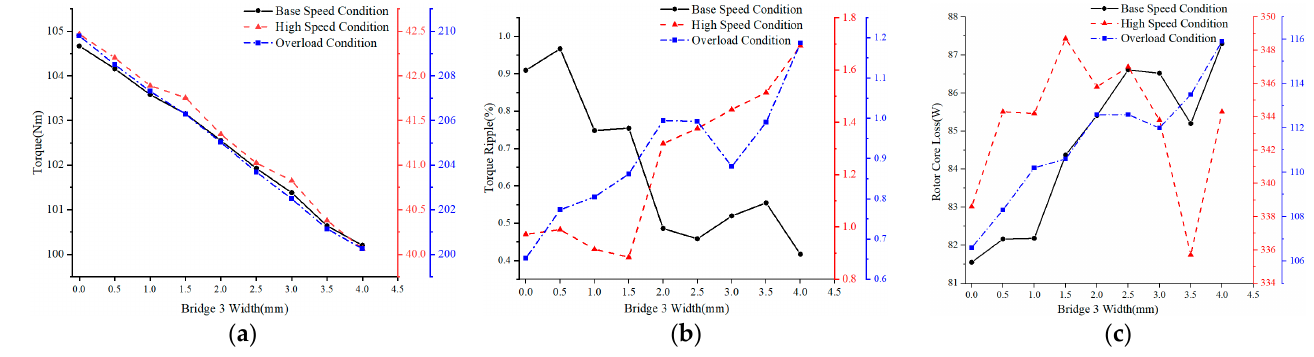
Figure 12. Motor electromagnetic characteristics with different bridge 3 width: ( a ) output torque, ( b ) torque ripple, ( c ) rotor core loss.